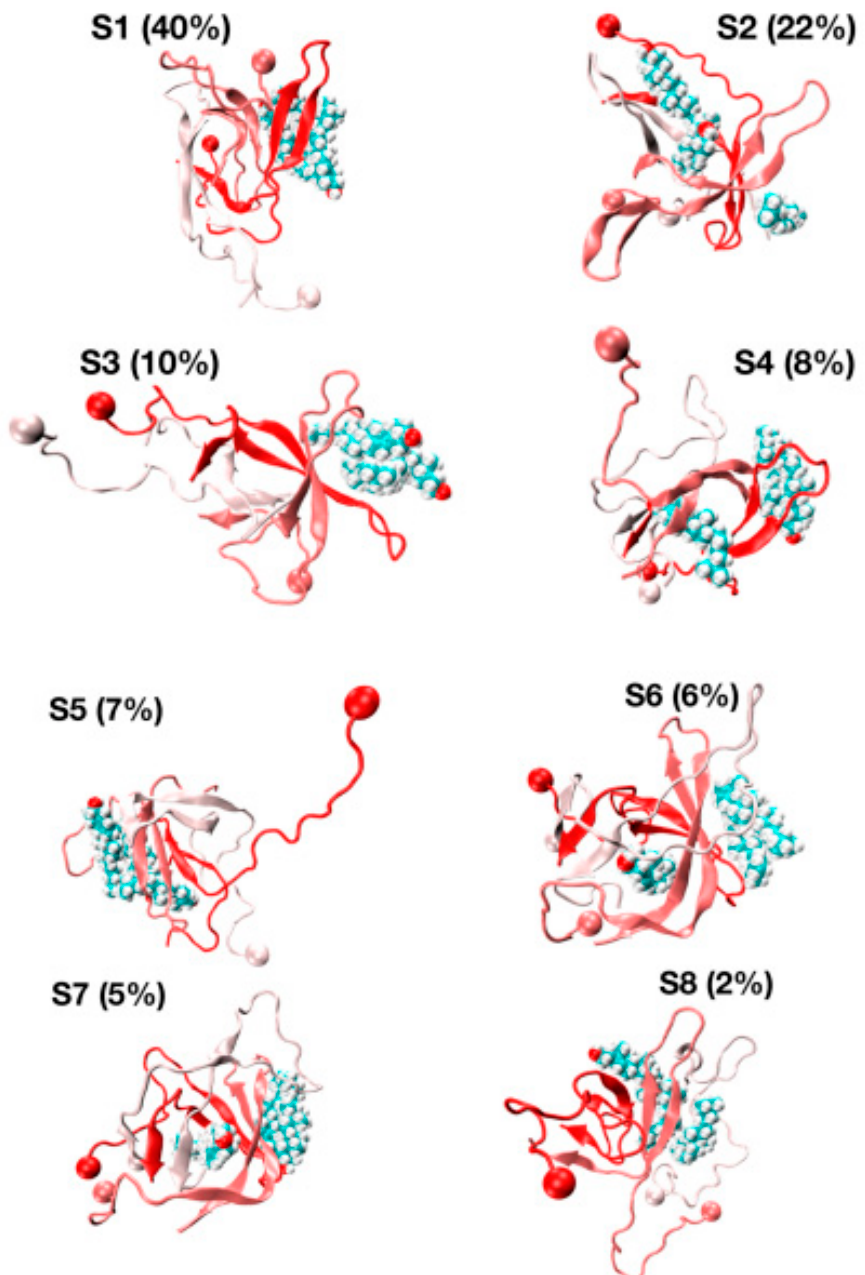
Figure 7. Representative structures and populations of eight free energy minima from REST2 simulation at 310 K. Chain A is in red, chain C is in white and chain B is in pastel pink. The ball shows the N-terminus of each chain. The cholesterols are visualized in all-atom and Van der Waals representations. The S3, S4, S6 and S7 minima, with a total population of 29%, have a β -strand content of 36% and share the same topological features: two peptides with highly twisted β -hairpins (chains A and B) covering distinct amino acids perpendicular to each other, and a third disordered and compact peptide (chain C) with no preferred interface with the other two chains. For instance, there is a small intermolecular β -sheet between residues V40–I41 and K28–G38 in S3 and between residues L34–V36 and V39–I41 in S4. The S5 state with a population of 7%, dominated by a coil (49%) with low β -strand content (29%),